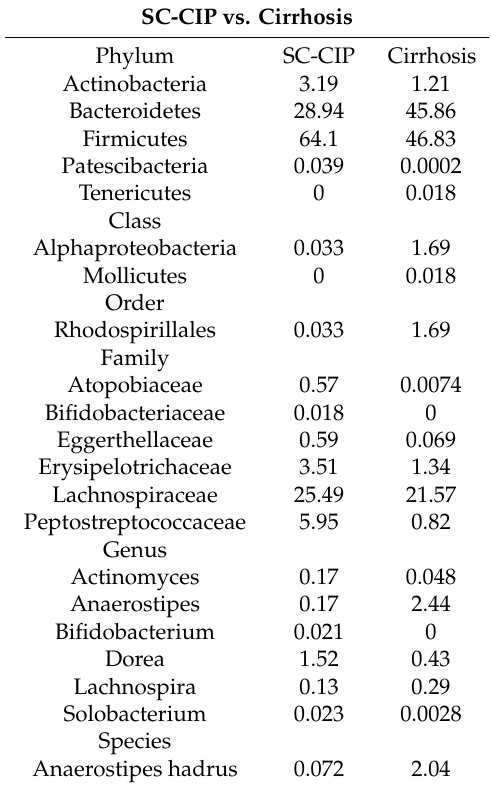
Table 9. Taxonomic di ff erences found with analysis of composition of microbiomes between SC-CIP and cirrhosis groups on all taxonomic